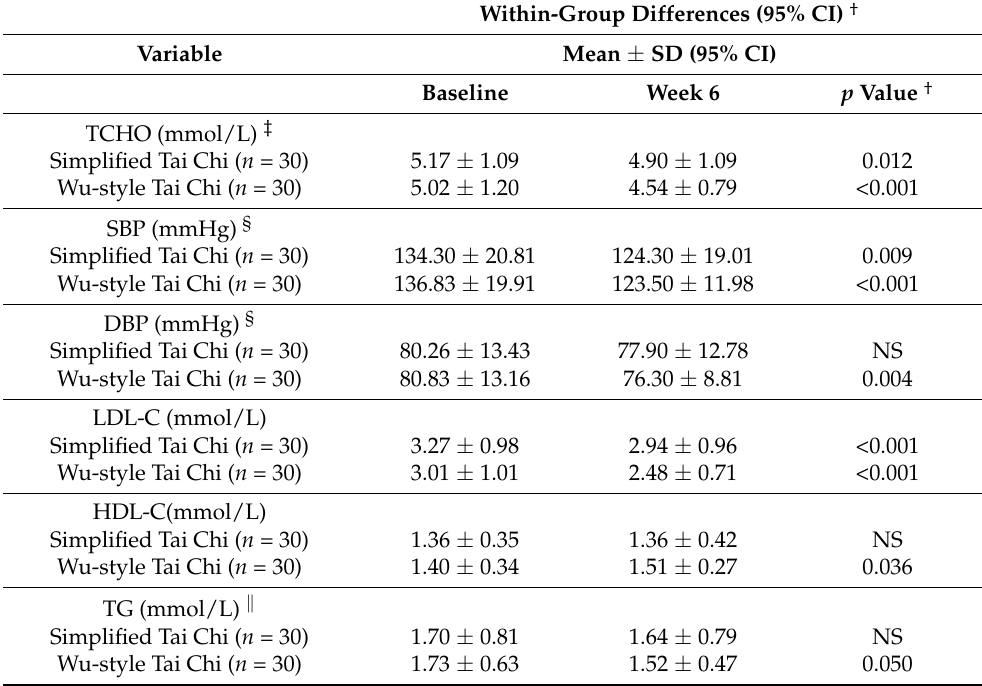
Table 2. Study measures, differences within groups at baseline and 6 weeks